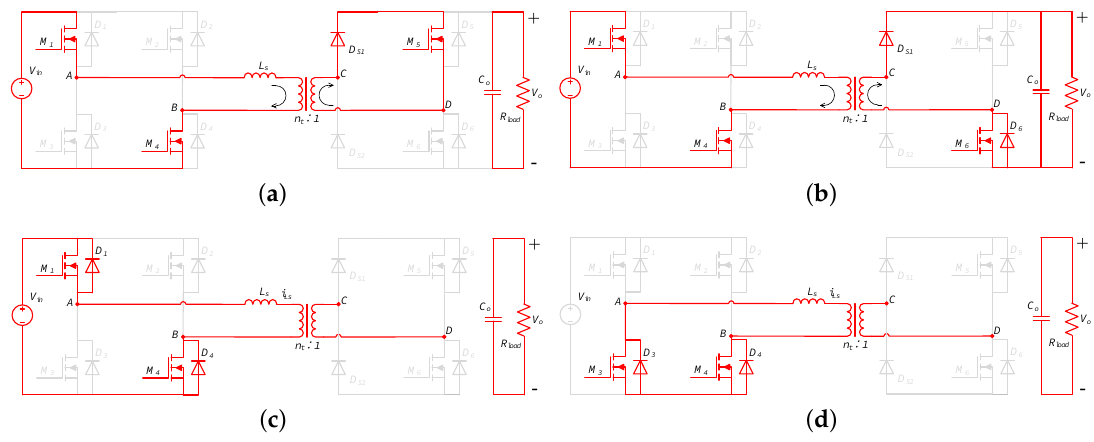
Figure 6. Equivalent circuits corresponding to the first four intervals in Mode C: ( a ) Interval 1 [0, φ − α ]; ( b ) Interval 2 [ φ − α , γ − α ]; ( c ) Interval 3 [ γ − α , π − α ]; ( d ) Interval 4 [ π − α , π ].